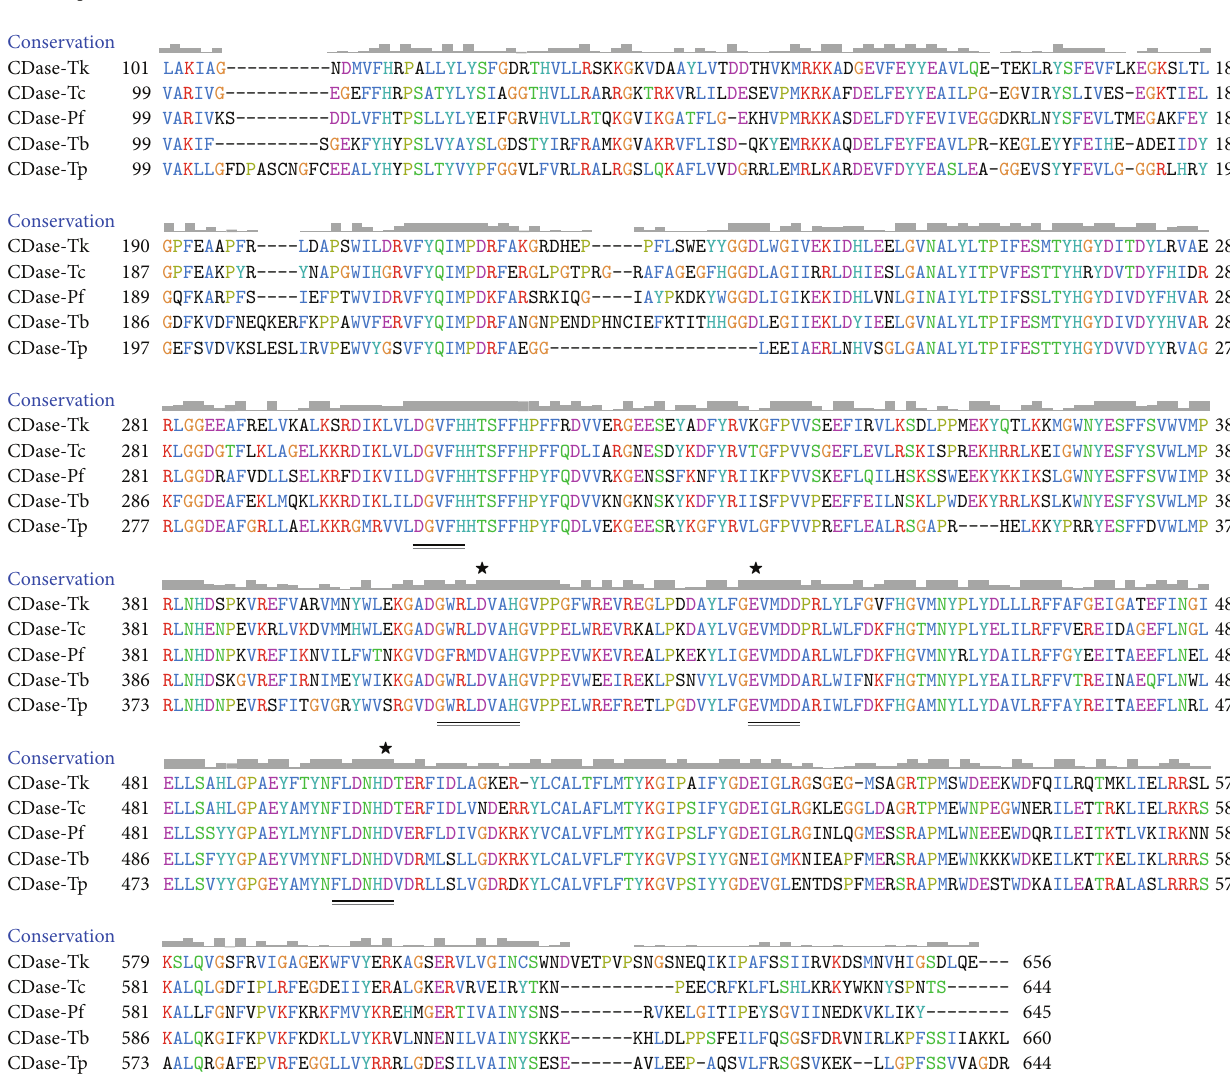
Figure 1: Sequence and structure analysis of CDase-Tk. Cyclodextrinase sequences from T. kodakarensis KOD1 (CDase-Tk, Tk1770), Thermococcus sp. CL1 (CDase-Tc, YP 006424883.1), Thermococcus sp. B1001 (CDase-Tb, BAB18100.1), Pyrococcus furiosus (CDase-Pf, NP 579668.1), and Thermofilum pendens Hrk 5 (CDase-Tp, YP 920858.1) were aligned. The solid line indicates the four consensus regions conserved in the GH13 family. The asterisks show the positions of the three active sites. The conservation level of each residue is indicated by the height of the bars above each residue. The number at the ending of each line of amino acids indicates the number of the amino acid